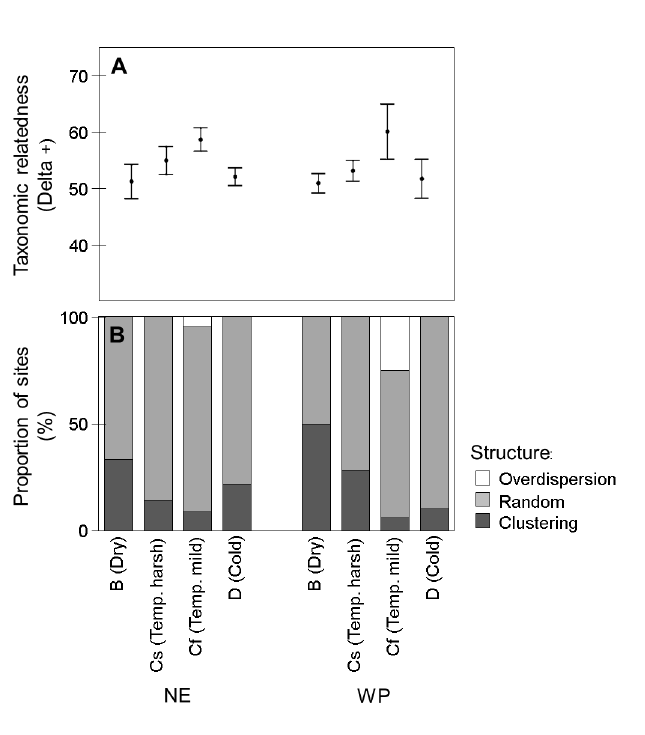
Figure 7. Patterns of taxonomic clustering among climates within each ecozone (NE = Nearctic, WP = Western Palearctic). (A) Mean ± SE values of Delta+, informing about taxonomic relatedness (relatively higher Delta+ values imply assemblages with taxonomically closer members); (B) % of sites presenting lower-than-expected taxonomic relatedness (H overdispersion), expected taxonomic relatedness (H